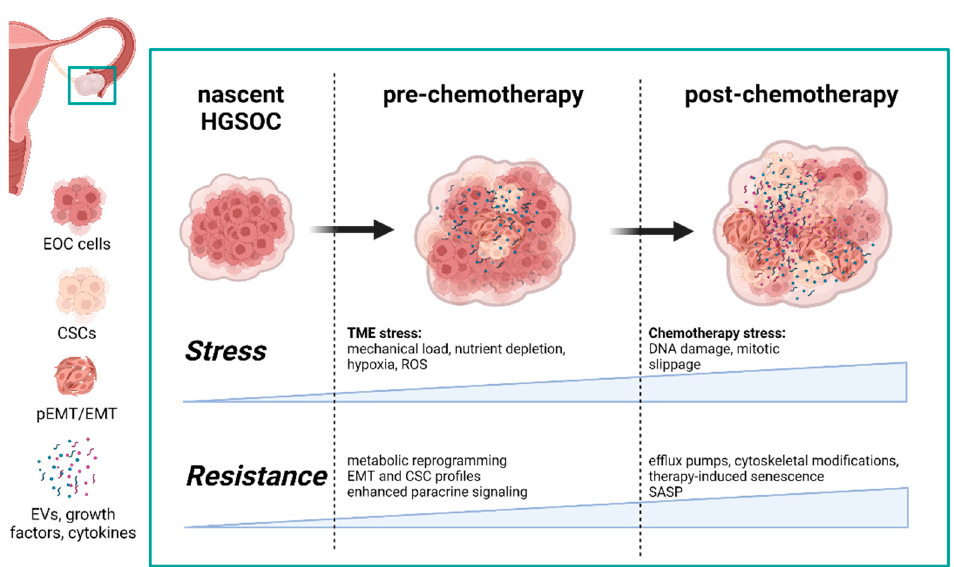
Figure 1. Both hypoxia in the tumor microenvironment and chemotherapy confer resistance to stress and, ultimately, chemotherapies. Each drives distinct changes in the TME composition in terms of cell populations and the secretome. Modifications in the HGSOC secretome as a result of TME stressors not only promote the development of chemotherapy-induced resistance, but are also expanded after exposure to anticancer drugs, thus reinforcing a protective and resilient TME. Abbreviations: (p)EMT—(partial) epithelial-to-mesenchymal transition; CSC—cancer stem cell; HGSOC—high-grade serous ovarian cancer; SASP—senescence-associated secretory phenotype; EV—extracellular vesicles (generated with BioRender, Toronto, Canada).